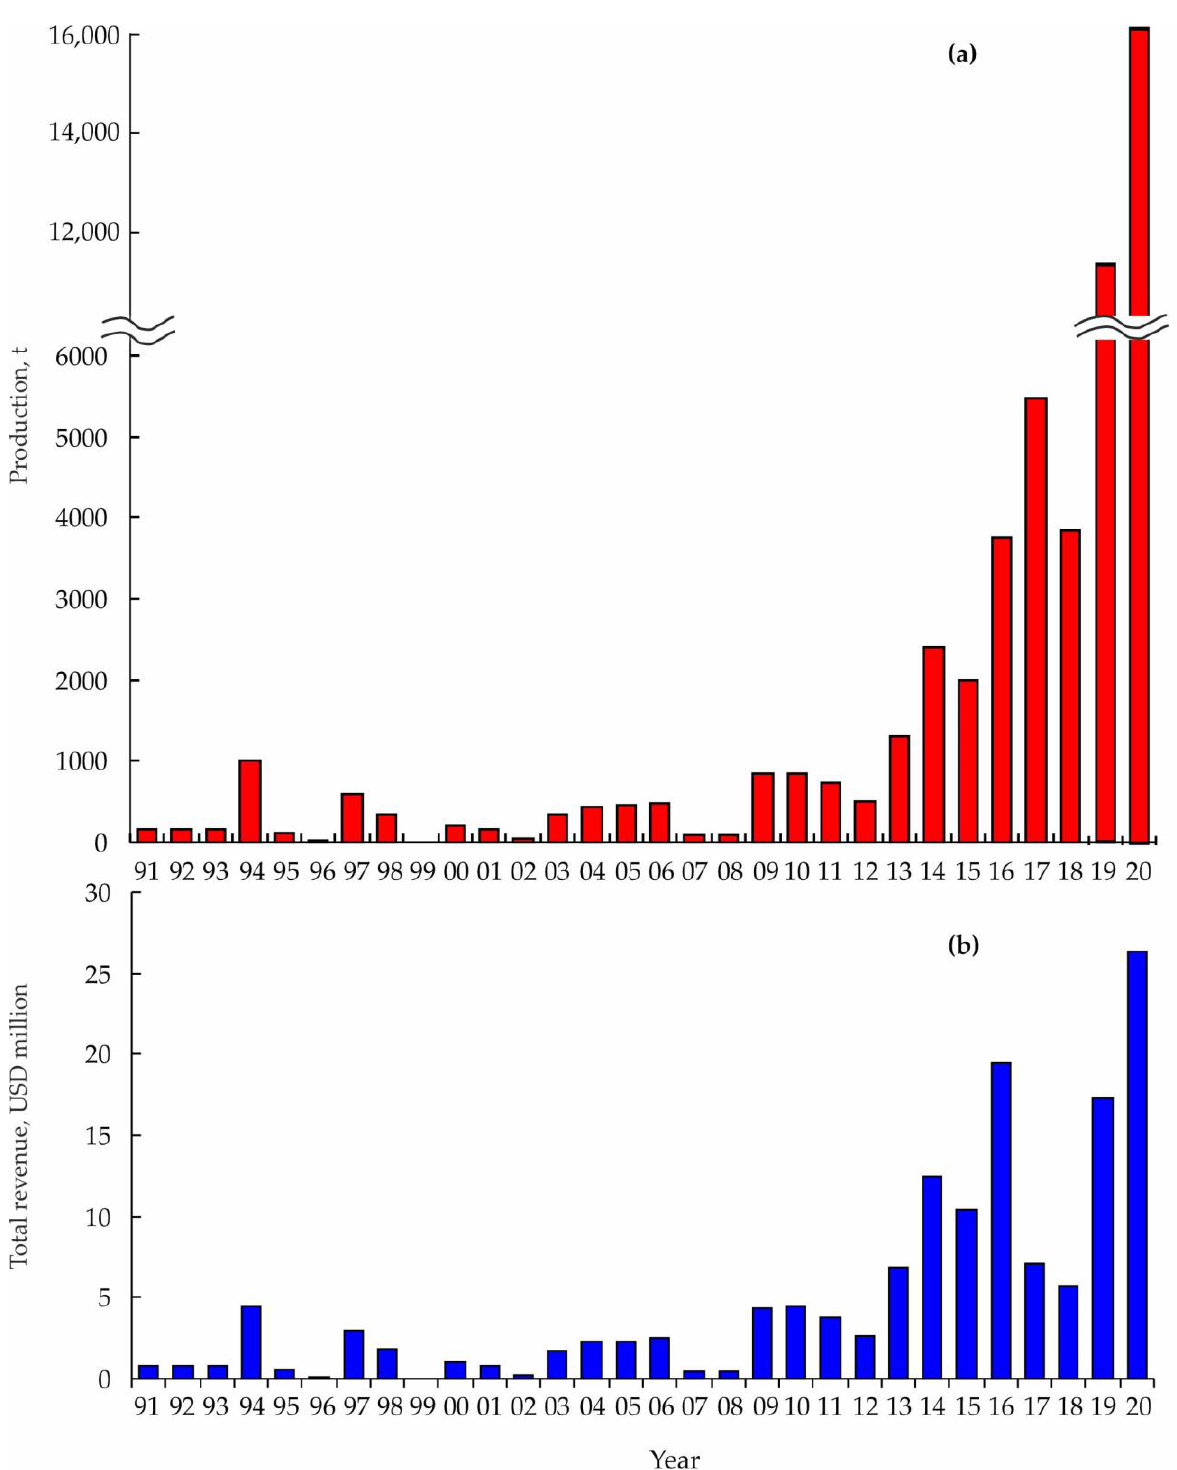
Figure 6. Total annual aquaculture production ( a ) and revenue ( b ) of Mizuhopecten yessoensis in Russian waters of the Sea of Japan [85].